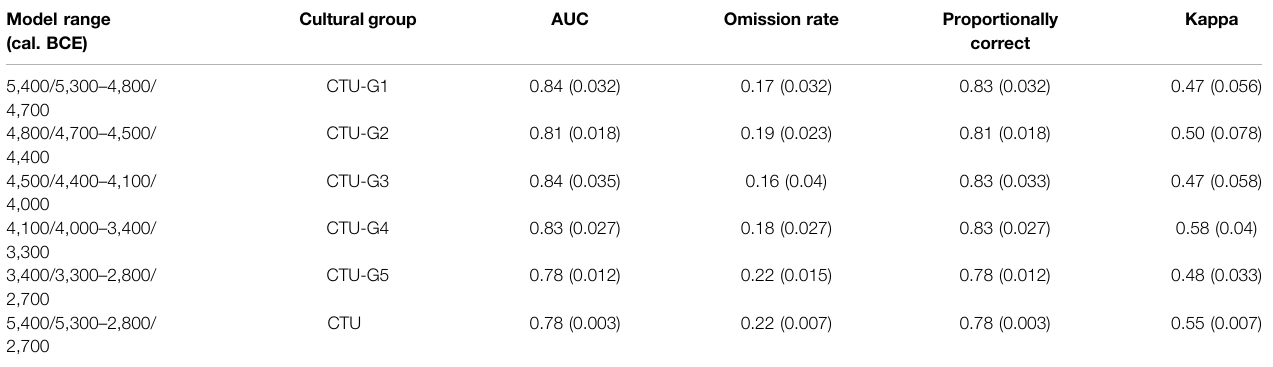
TABLE 6 | Model performance of CTU groups and CTU niches reconstructed using average values of bioclimatic variables provided by CCSM4, MIROC-ESM, and MPI- ESM-P, and DEM-derived terrain variables. Model range (cal. BCE)